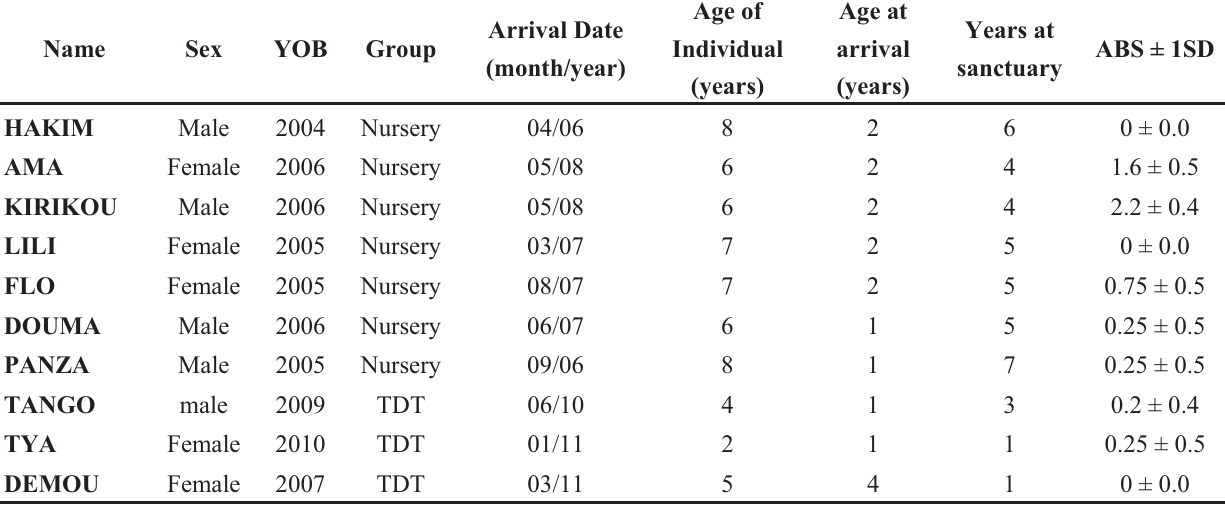
Table 1. Summary of each subject’s sex, year of birth (YOB), current age (as of January 2012), age upon arrival to the Centre for Conservation of Chimpanzees (CCC), the number of years spent at sanctuary (as of January 2012), and average abnormal behavior likert-scale [35] score upon arrival